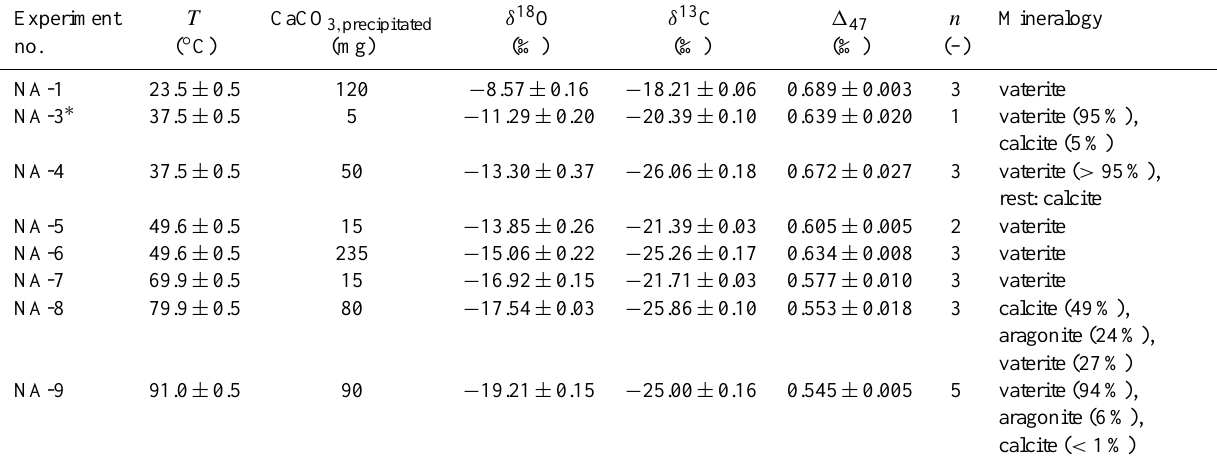
Table 2. Mineralogical and isotopic results of the vaterite precipitation experiments. The mineralogy was determined by XRD analysis (Sect. 3.2). The n values give the number of replicates measured for isotopic analysis. The (cid:49) 47 value is given in the absolute reference frame of Dennis et al. (2011) and is corrected for the acid digestion reaction.